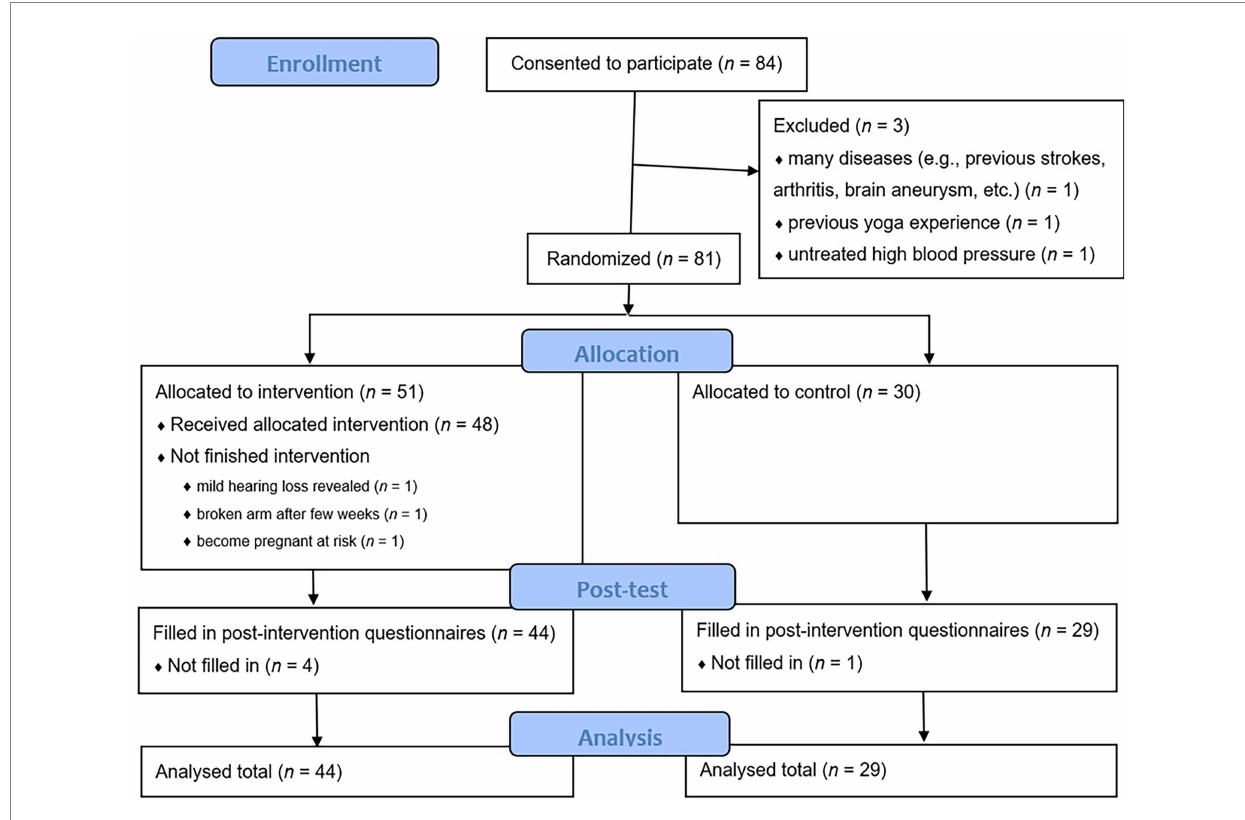
FIGURE 1 Number of participants at each point of